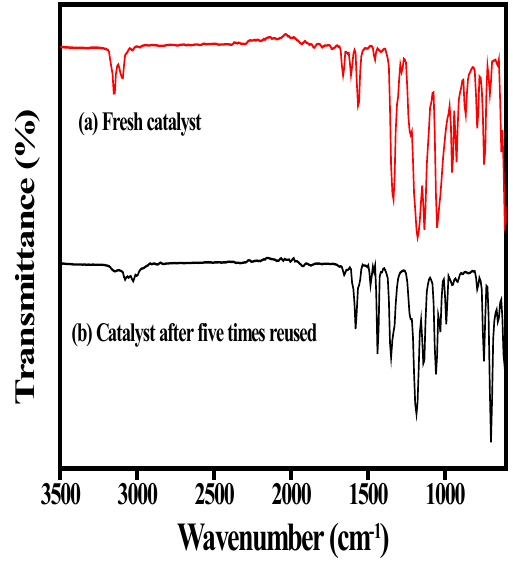
[NTf ] /DMAP RTILs for synthesis 2 2 2